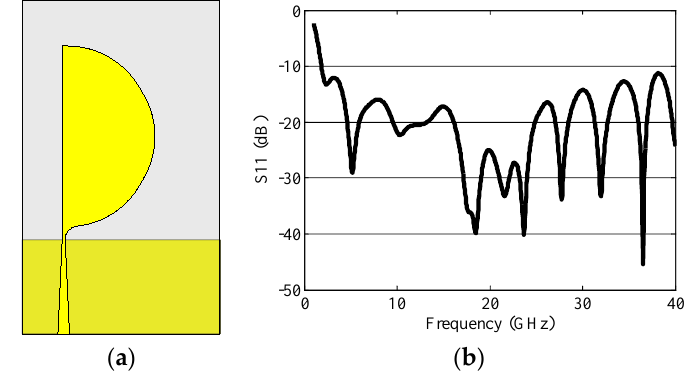
Figure 1. ( a ) The schematic design of single super wide band (SWB) antenna element and ( b ) S11.